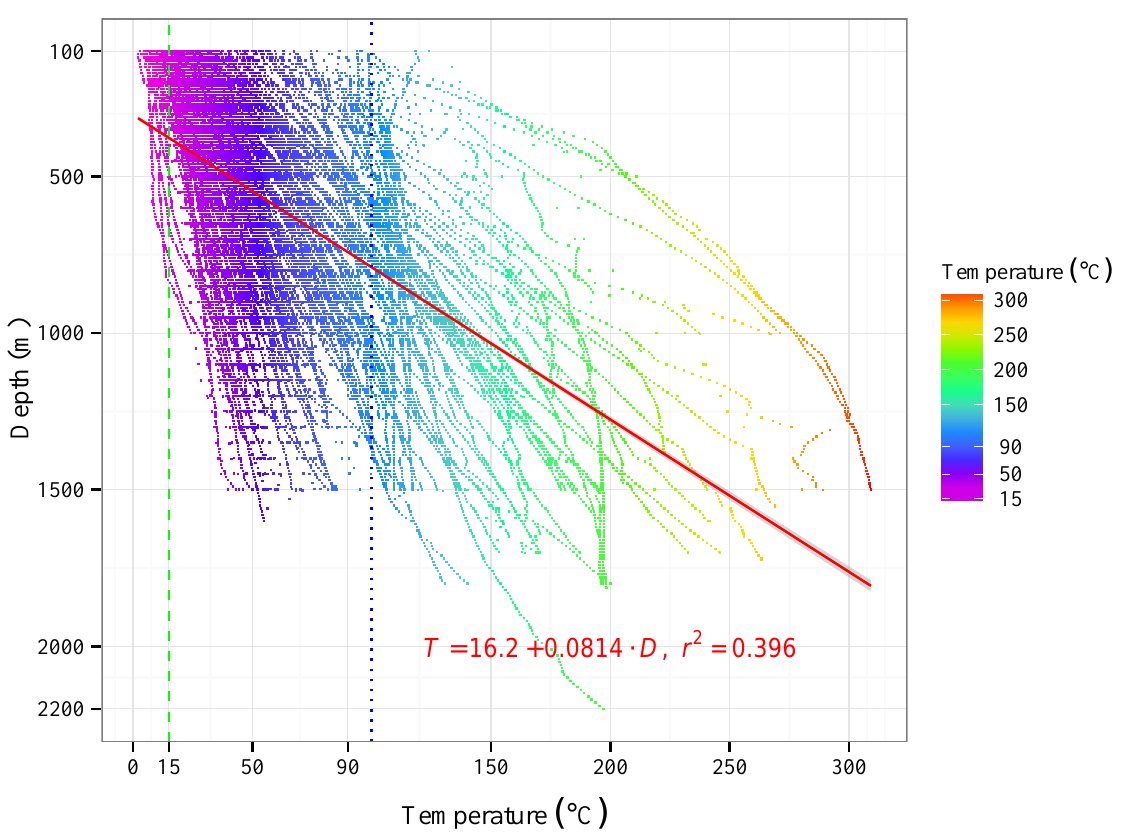
Figure 4. All temperature profiles with depth. The red line denotes a linear regression of the relationship between temperature and depth and shows a geothermal gradient 81 ◦ C /km. The dotted blue line shows 100 ◦ C